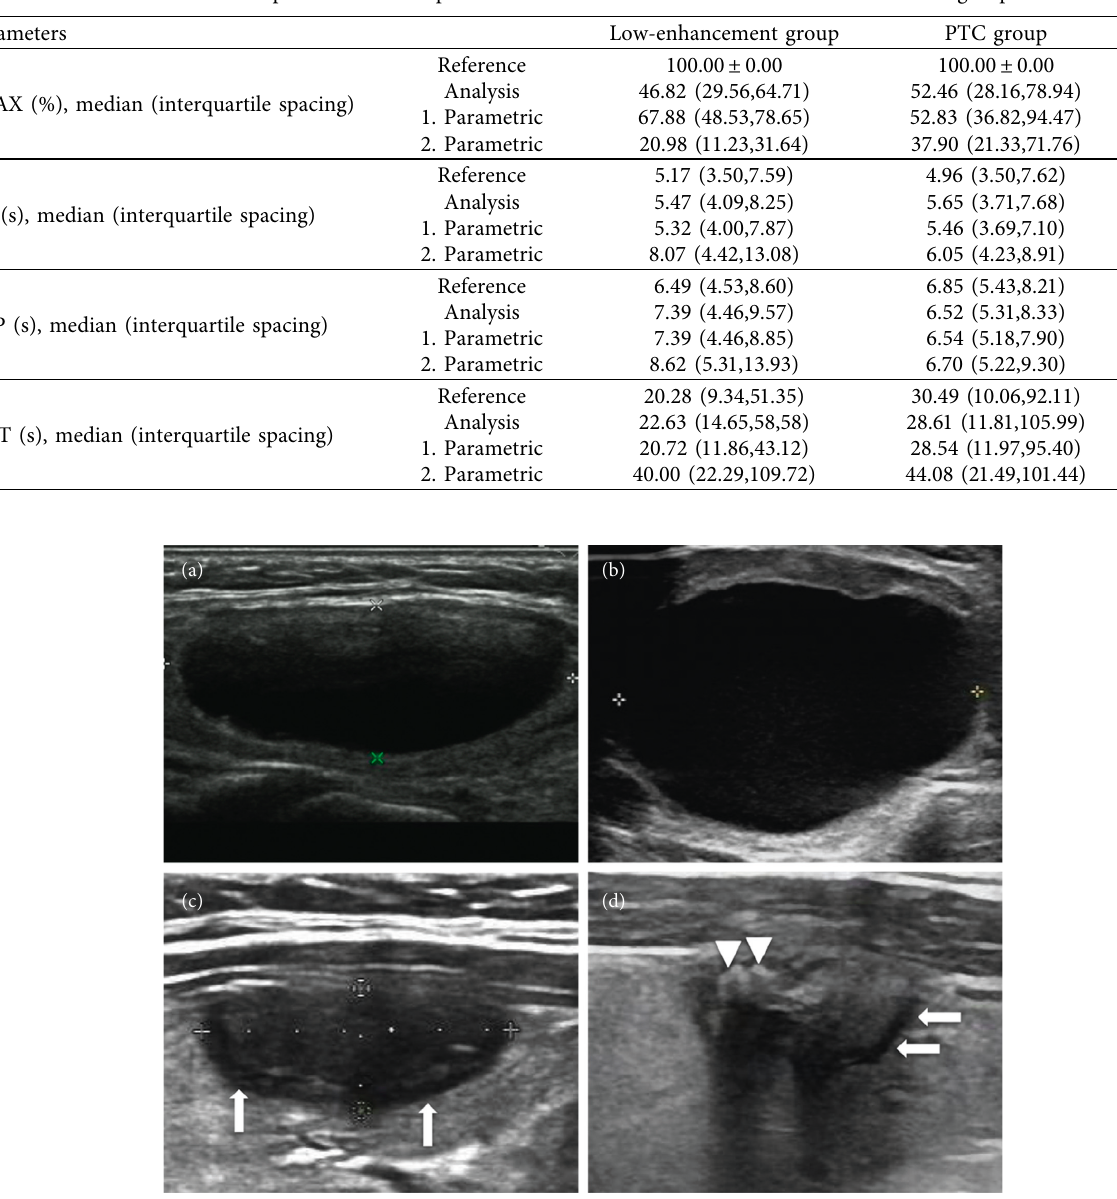
Figure 7: (a) A 44-year-old female was found a thyroid cystic nodule in a health examination, and it was classified as TI-RADS 2. (b) 1.5 years later, the patient felt neck pain, and also a mass with palpation. Ultrasound examination showed that the cyst was enlarged with the maximum diameter 40mm, and dense punctate echoes could be seen in the capsule cavity, which was considered as hemorrhage in the cyst. (c) 2 years later, ultrasound showed that the nodule shrank and became solid inside, and the maximum diameter of the nodule was 16mm. Arrows show a hypoechoic halo around nodules, and the margins of nodule were still clear. (d) 3 years later, the nodule was even smaller, and the hypoechoic halo around the nodule was still visible (arrows), but the margin became blurred. The triangle pointed to coarse calcifications, suggesting that necrotic substances exist for a long time. Echo attenuation behind the nodule suggested that fibrosis in the nodule might be